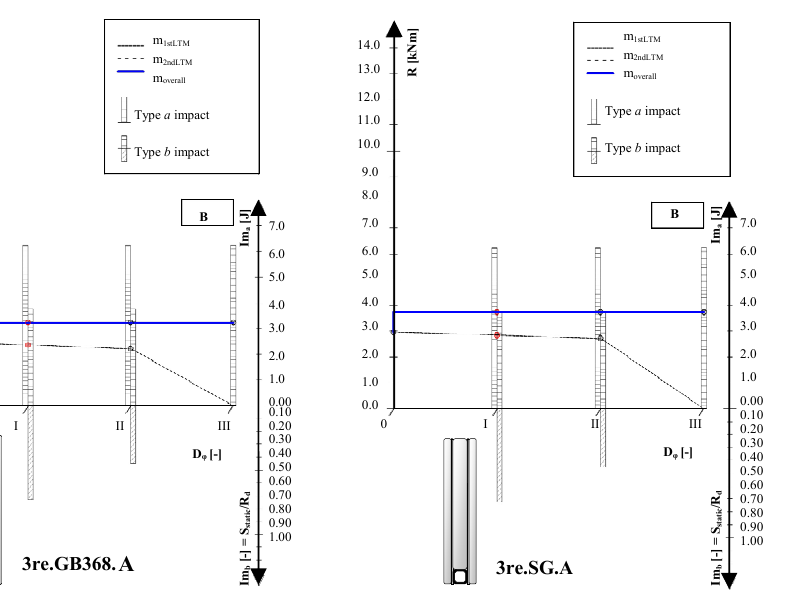
Figure 15: Element Safety Diagram for triple layer, GB368-bonded, annealed glass beam.